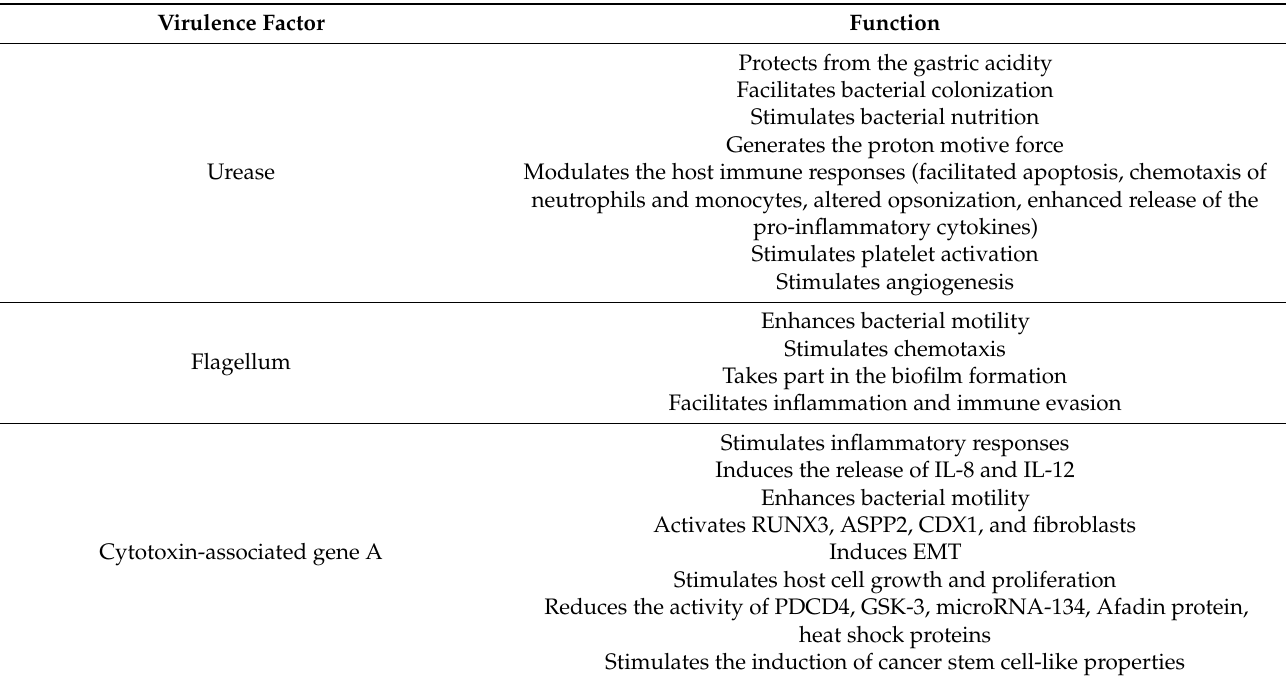
Table 1. Characteristics of Helicobacter pylori virulence factors that facilitate carcinogenesis and protect the bacterium from the gastric microenvironment, enabling colonization and